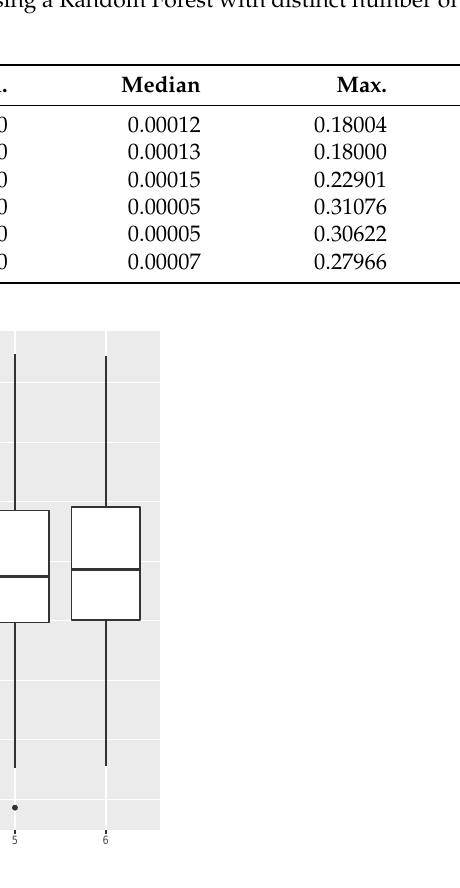
Figure 11. Error dispersion of the b I estimate using distinct Random Forest parameters. The errors in the estimation of the mass are shown in Table 8, while the dispersion using all Random Forest methods are compared in Figure 12. The parameters tree = 200 and split = 5 provided the best mass predictor, based on the median error. For the estimation of P critical , the error data is given in Table 9, with the error dispersion shown in Figure 13 where, based on the median error, the parameters tree = 200 and split = 3 provided the best P critical predictor. Table 8. Error statistics of the mass estimate using a Random Forest with distinct number of trees and